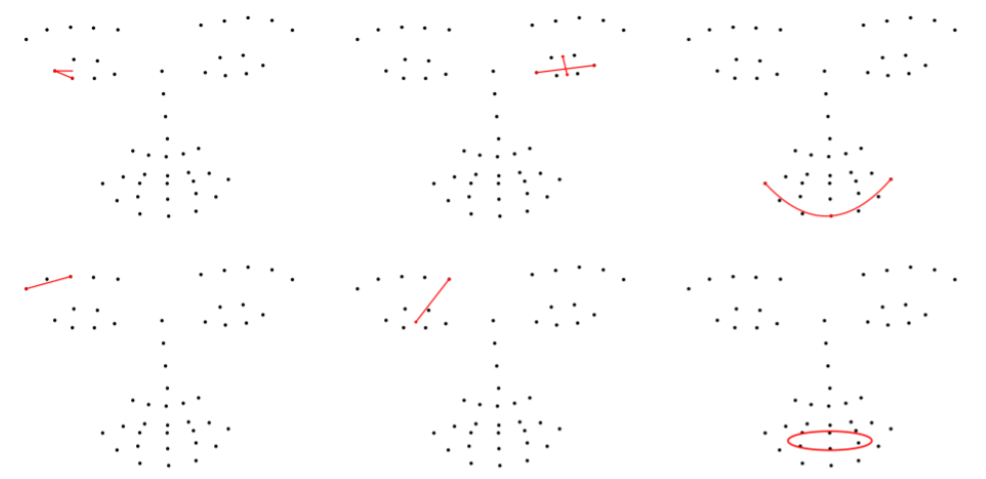
Figure 2. Examples of how geometric features are displayed based on the landmarks they originate from. From left to right, top to bottom, the geometric features displayed are: lower eye outer angles (L), eye aspect ratio (R), bottom lip curvature, outer mid eyebrow slope (L), eye—inner eyebrow distance (L), mouth opening/mouth